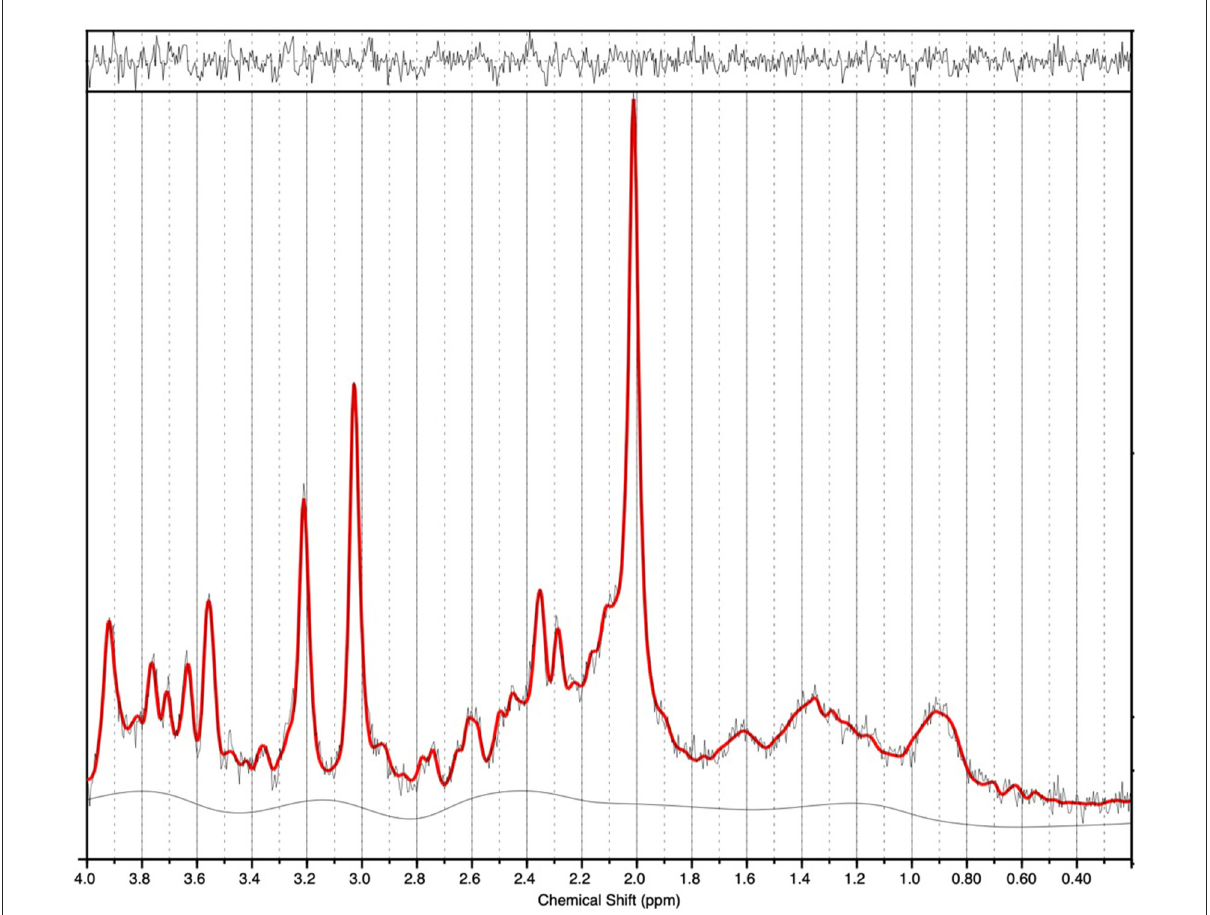
FIGURE2 1 H-MRS spectra (for a single subject). LCModel output is shown with output of the fit (red) overlaid on the acquired spectrum (black). The estimated baseline is displayed under the spectrum in black. For this single subject example, a metabolite FWHM of 0.033 ppm and SNR of 33 was